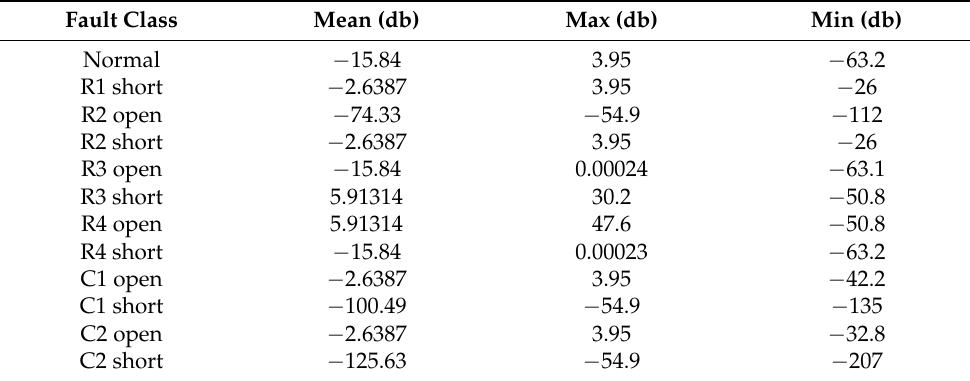
Table 1. Statistical analysis of circuit frequency response.